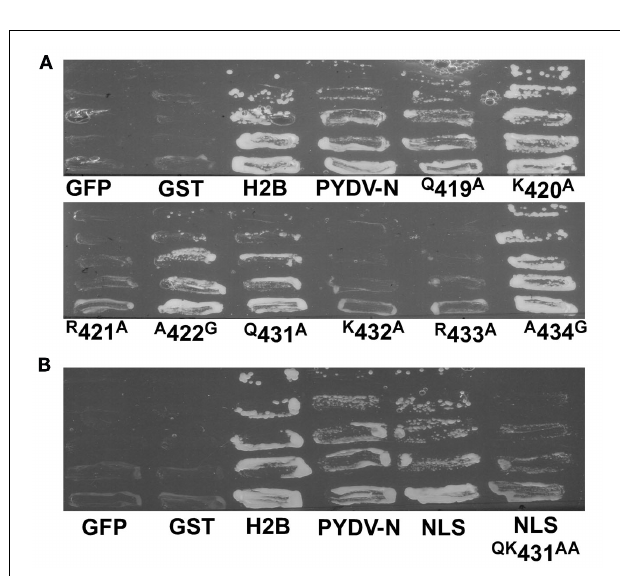
FIGURE 3 | Confocal micrographs showing results of BiFC assays to determine interactions between importin- α and PYDV-N mutants. Interaction assays were conducted in leaf epidermal cells of transgenic N. benthamiana expressing fluorescent nuclear marker protein fusion. Panels 1,